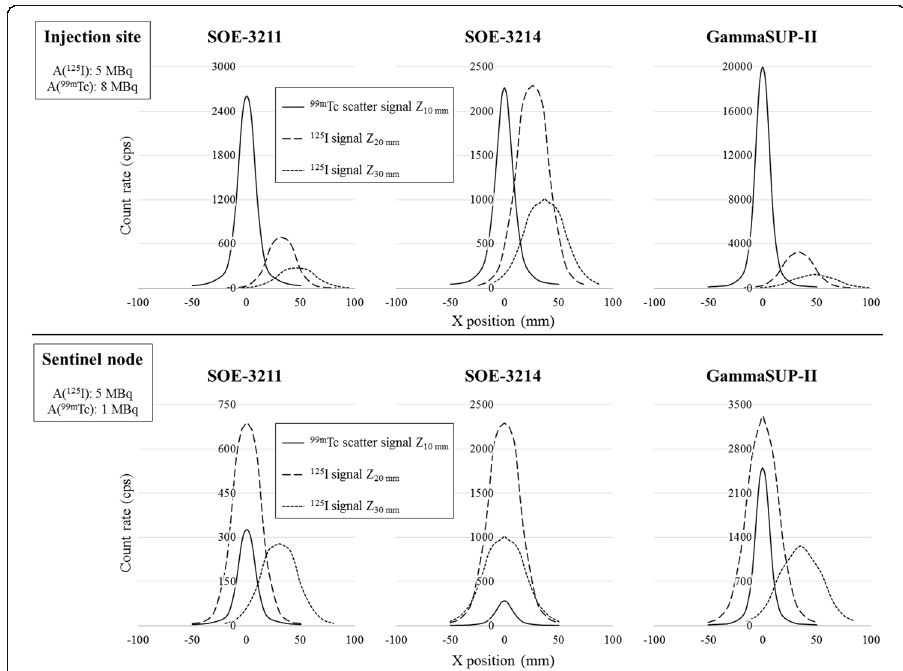
Fig. 7 Shift Index assessments from the in vitro simulation of an 8 MBq 99m Tc injection site and a 1 MBq three